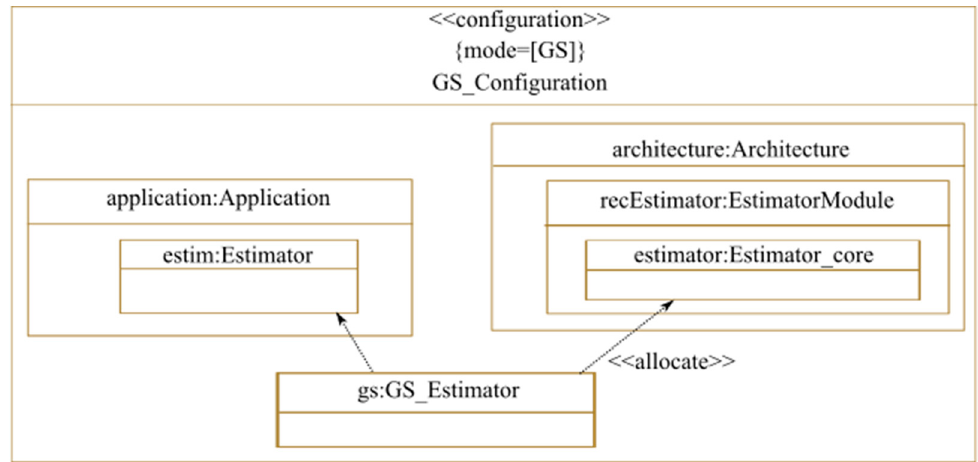
Figure 12. Reconfiguration controller modes.